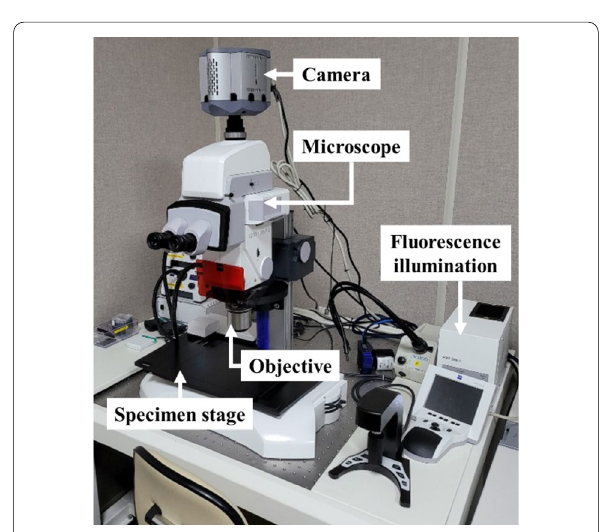
Fig. 9 Fluorescence microscope (Axio Zoom.V16, Zeiss,